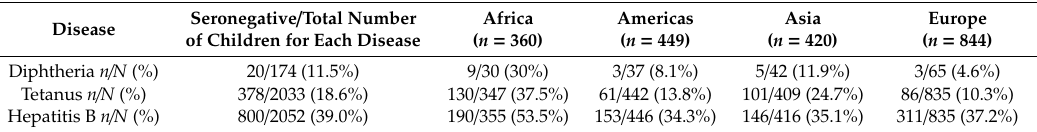
Table 3. Percentages of seronegative children in the study for diphtheria, tetanus, and hepatitis B by continent of